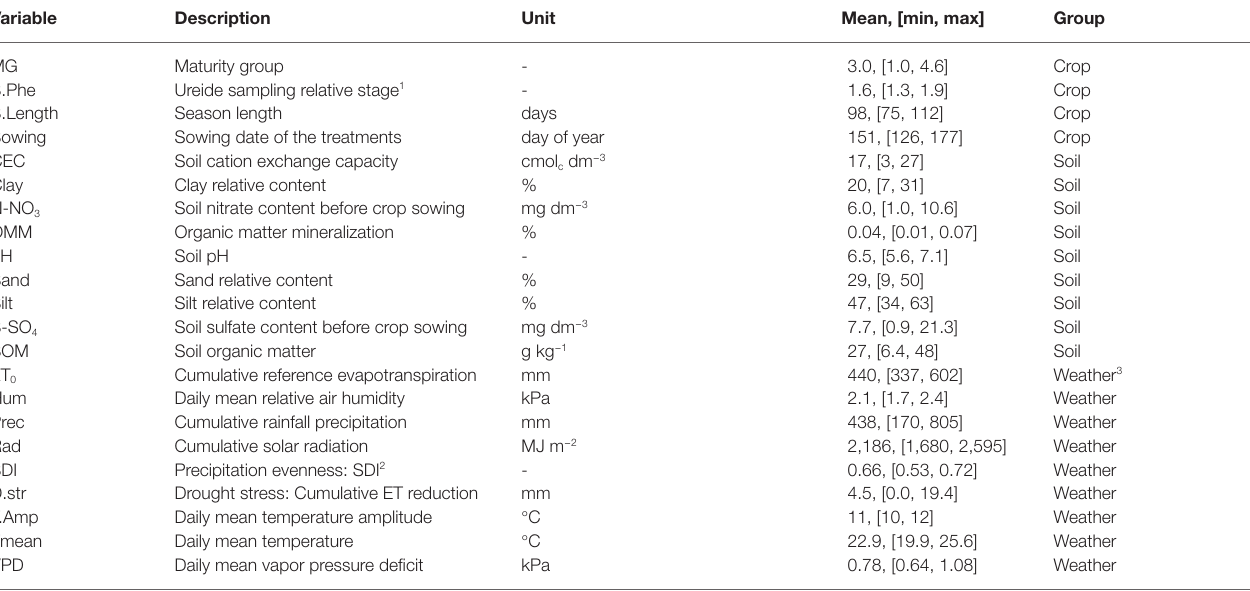
TABLE 1 | Crop, soil, and weather variable description, units, means, and range of observations.